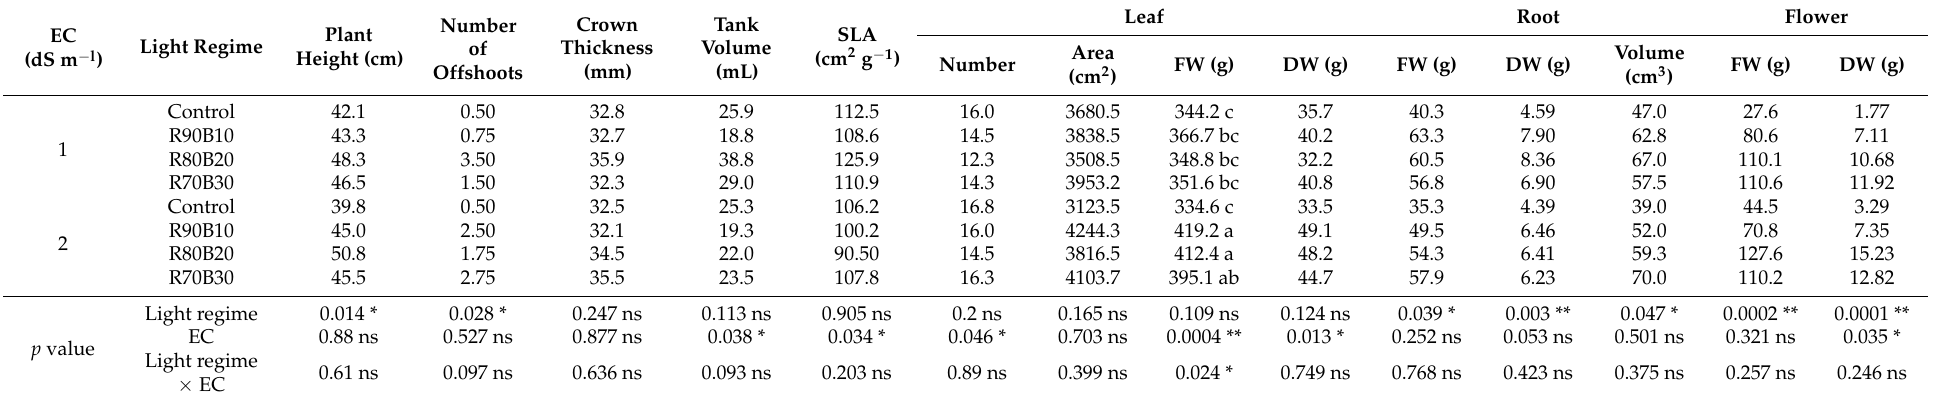
Table 2. Effect of supplementary light and nutrient solution electrical conductivity (EC) on growth and morphology of Aechmea ’Primera’ plants. The light treatment included control (no supplementary light), R90B10 [90% red (R) and 10% blue (B)], R80B20 (80% R and 20% B), and R70B30 (70% R and 30% B), while the EC values employed were 1 and 2 dS m − l . Four replicate plants were assessed per treatment. In traits, where the interaction of the two factors (light regime, EC) was significant, different letters indicate significant differences. FW, fresh weight; DW, dry